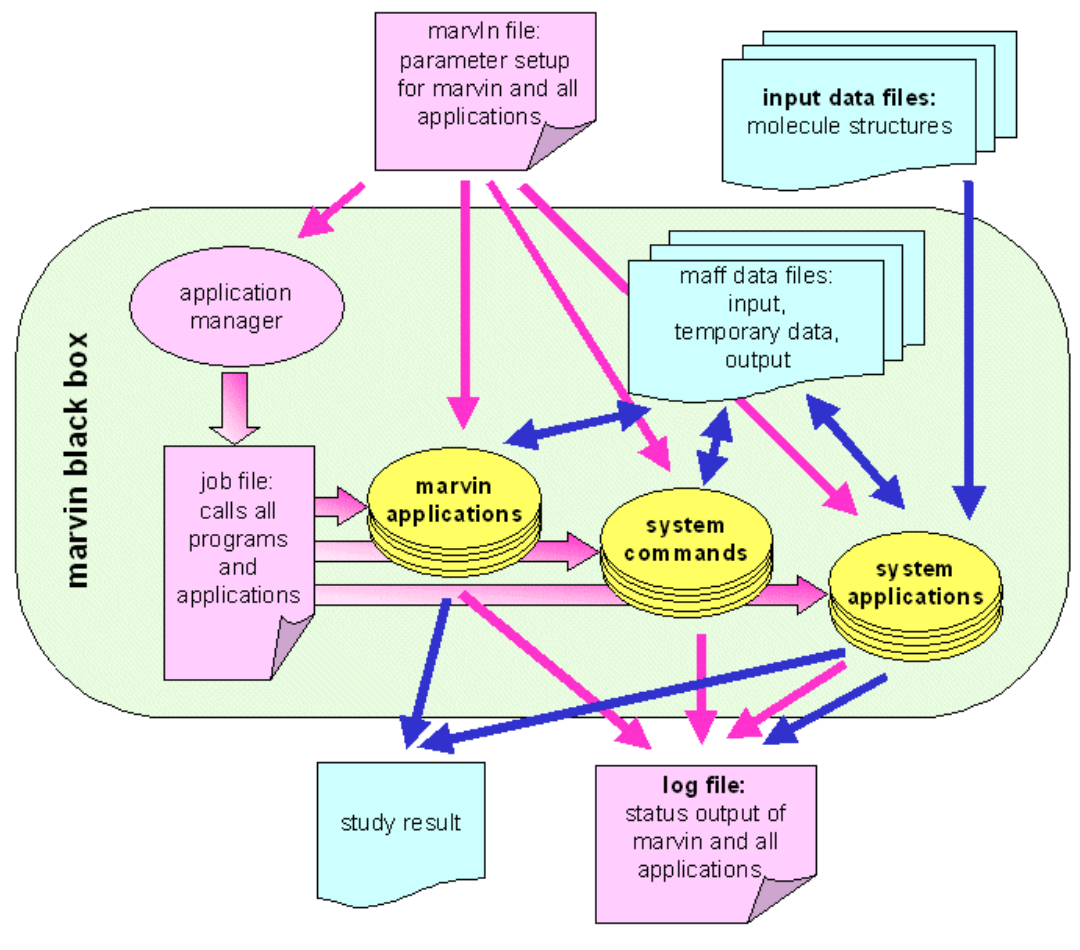
Figure 3: Control flow and data flow of a marvin study. The user can apply marvin as a black box. Only marvin input file and study results must be handled manually. The entire marvin study runs automatically and is controlled by the APM, which reads the setup from the input file. Blue arrows indicate data flow, magenta arrows indicate control